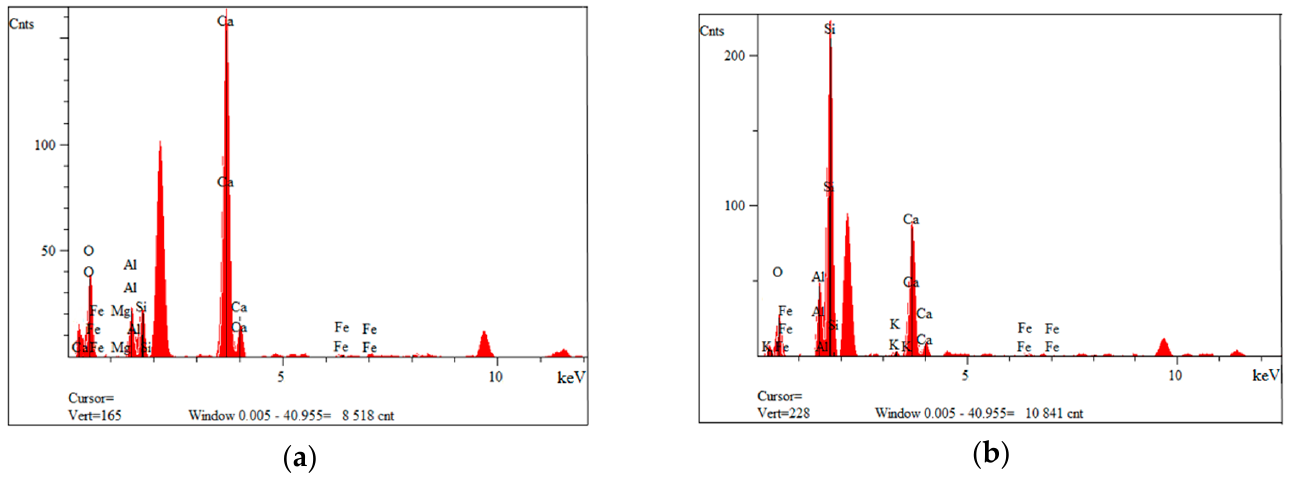
Figure 6. EDS analysis of fraction II from wind turbines: ( a ) for point 1 of Figure 5b; ( b ) for point 2 of Figure 5b.